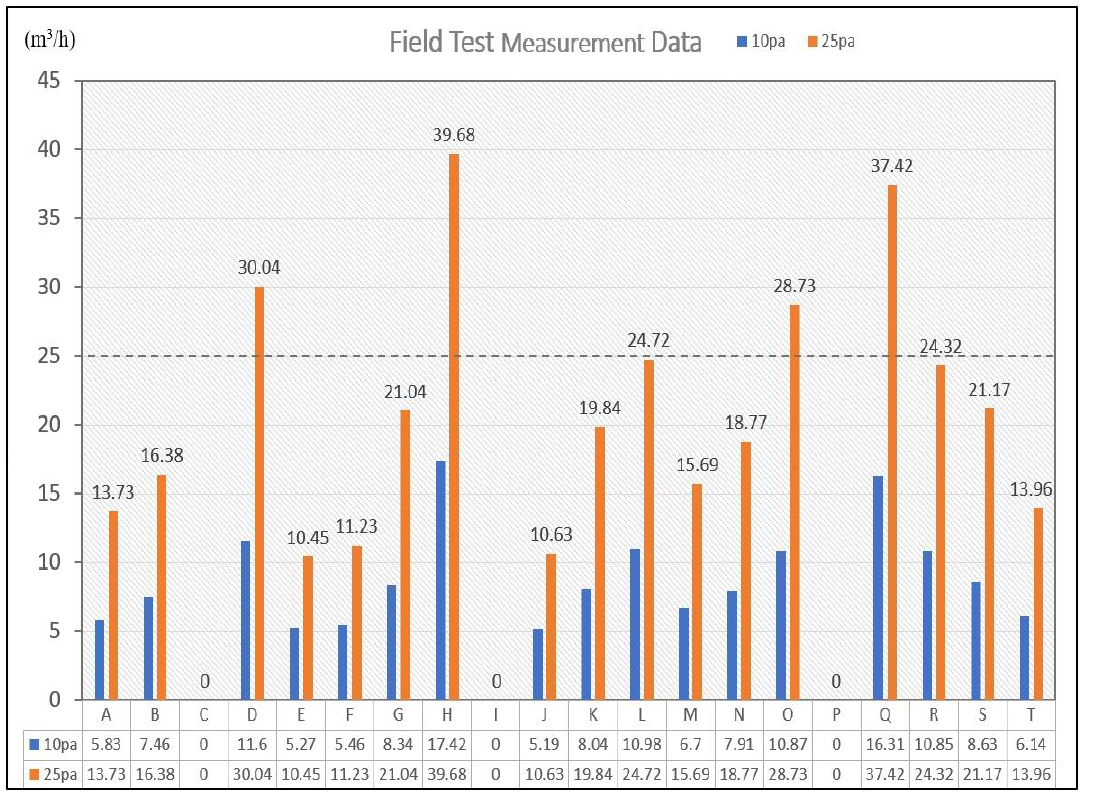
Figure 6. Field test measurement data.